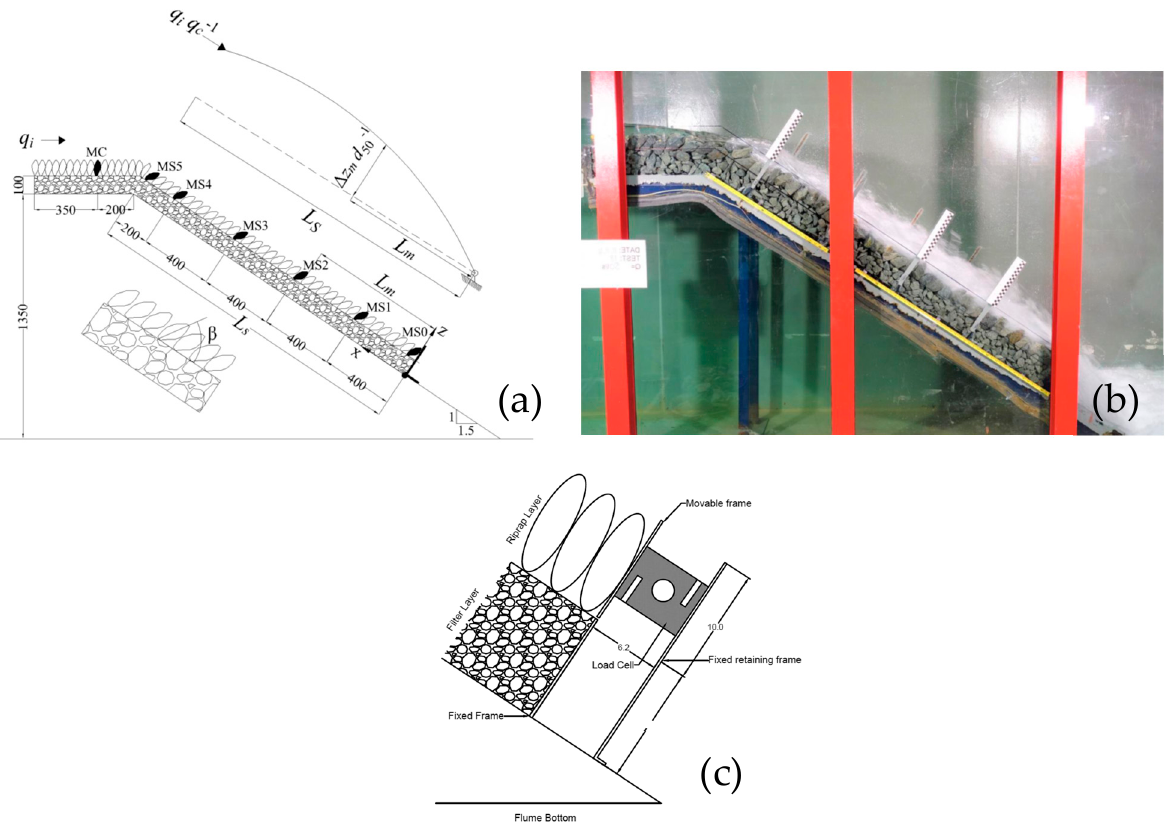
Figure 4. From Ravindra et al. [24], ( a ) depiction of experimental set-up of riprap model supported at the toe, ( b ) image of placed riprap model with such setup and ( c ) toe support positioning, from [25].